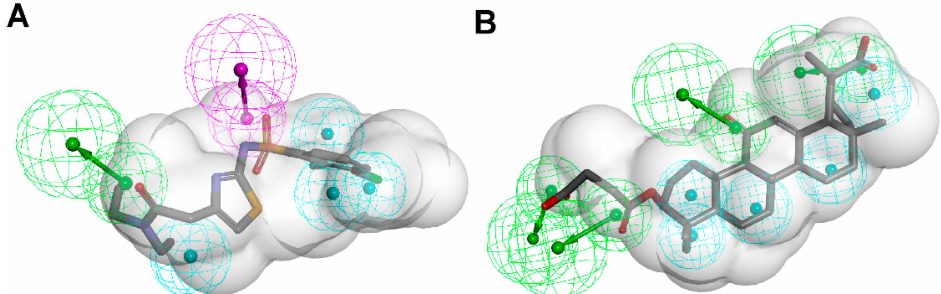
Figure 7. The selective ( A ) and nonselective ( B ) 11 β -HSD1 pharmacophore models reported in the study by Schuster and Maurer [106]. The training compounds CAS 376638-65-2 ( A ) and carbenoxolone ( B ) are aligned to the models. The 11 β -HSD1-selective model consisted of four H features (blue), one HBA (green) and one HBD (magenta) feature and a shape restriction. The nonselective 11 β -HSD model contained five H, four HBA features and also a shape